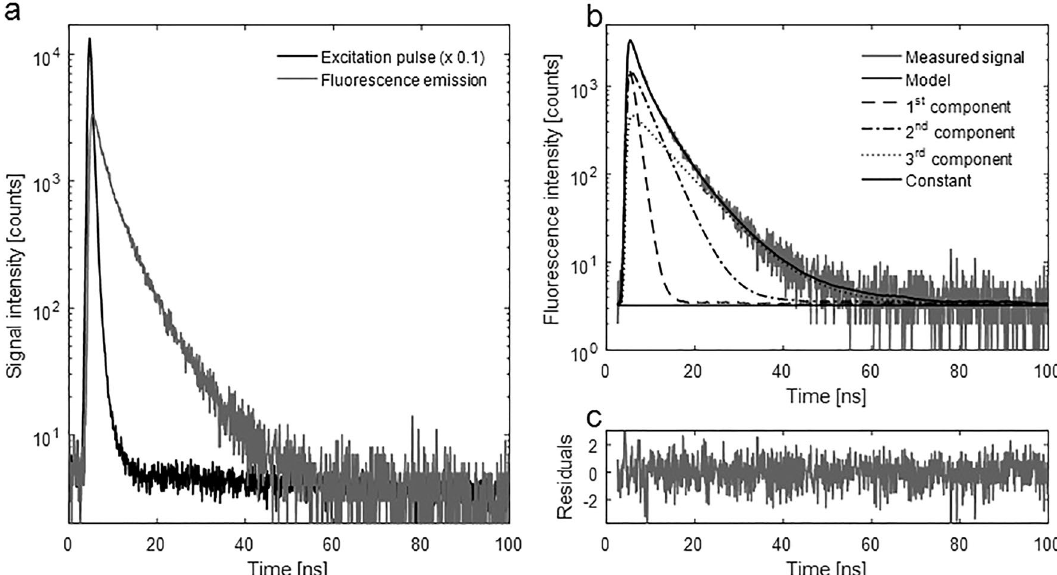
Figure 1. The decomposition of fluorescence lifetime (FLT) decay on particular components: ( a ) the signal intensity of plasma at 350 nm, ( b ) the model of three exponential fluorescence decay ( χ 2 = 1), ( c ) the residuals of the